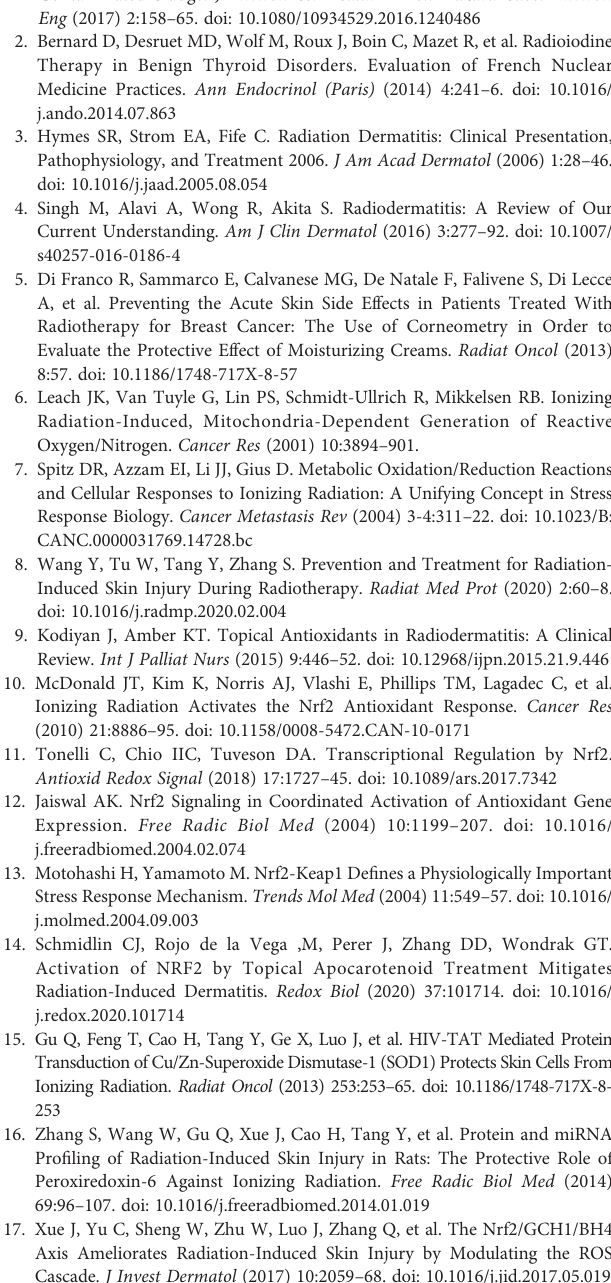
Supplementary Figure 4 | (A) The proliferation of HaCaT cells at 24 hours after irradiation was measured in an EdU incorporation assay by confocal microscopy. (B) The proliferation of WS1 cells at 24 hours after irradiation was measured in an EdU incorporation assay by confocal microscopy. Supplementary Figure 5 | (A) Representative skin images of the indicated groups at 30 days after 30 Gy irradiation. (B) Representative skin images of the indicated groups at 30 days after 45 Gy